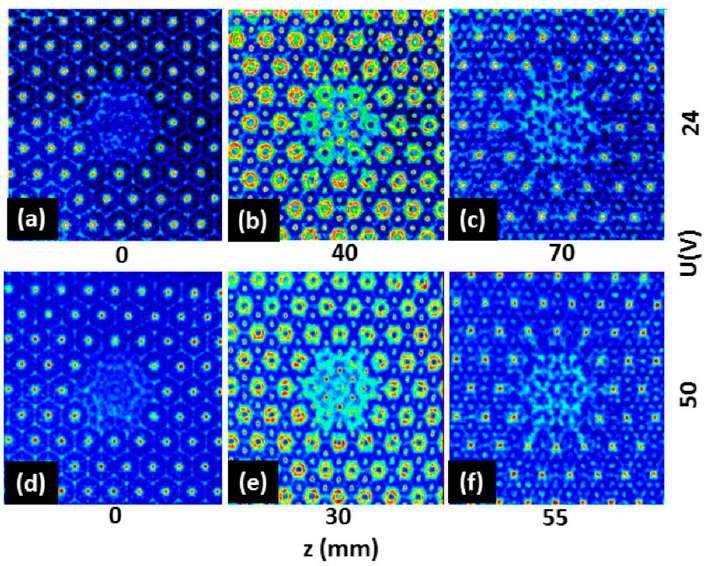
Figure 12. Configuration Com 5 : Experimental demonstration of tunable nondiffracting self-imaging with a hexagonal axicon array programmed into the SLM and an illumination by a fluid lens of electrically steerable focal length. The pictures show the voltage-dependent axial shift of the integer self-imaging planes and an intermediate fractal plane corresponding to alternating phases (FOV about 3.3 × 3.3 mm on CCD detector, spatial scales slightly adapted to show the geometrical similarity). The different distances for two voltages 24 V ( a – c ) and 50 V ( d – f ) indicate the axial tuning (laser source: diode laser, 790 nm).